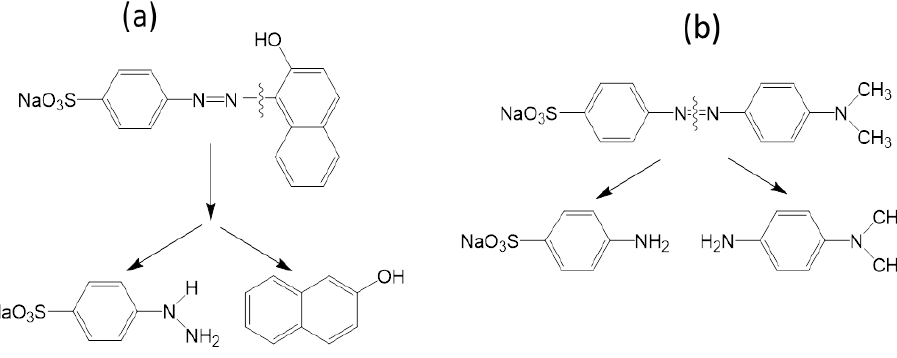
Figure 8. Proposed decolorization mechanism of OII ( a ) and MO ( b ) under visible light.